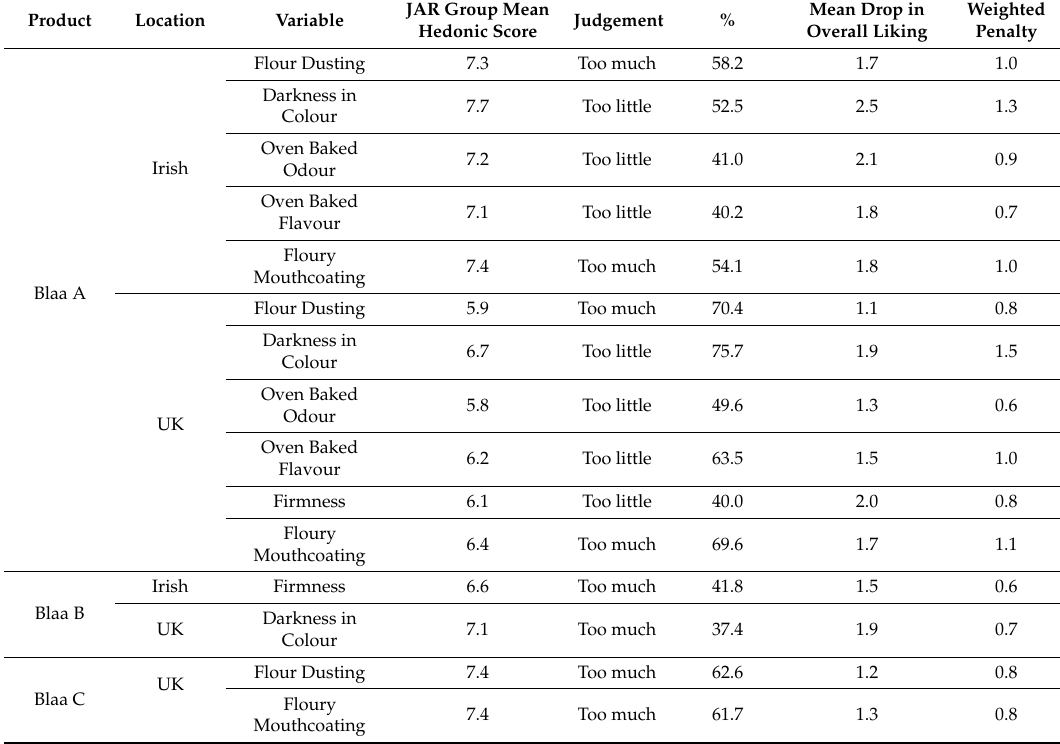
Table 3. Penalty analysis results for all attributes with a weighted penalty > 0.6